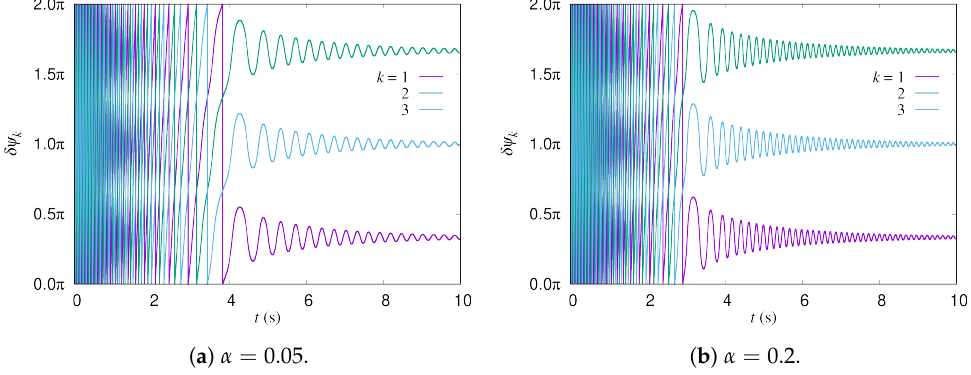
Figure 6. Time evolution of phase differences δψ k = ( ψ 11 + ψ 2 k ) mod2 π for α = 0.05 and 0.2 in the CD layout with 10mm